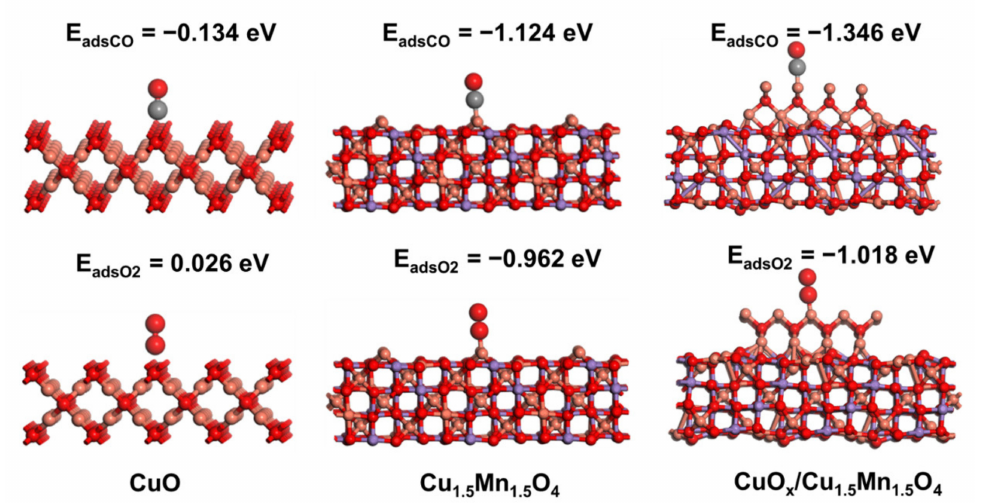
Figure 8. The side views of CO and O 2 adsorption on the surfaces of CuO, Cu 1.5 Mn 1.5 O 4 , and CuO x /Cu 1.5 Mn 1.5 O 4 ,